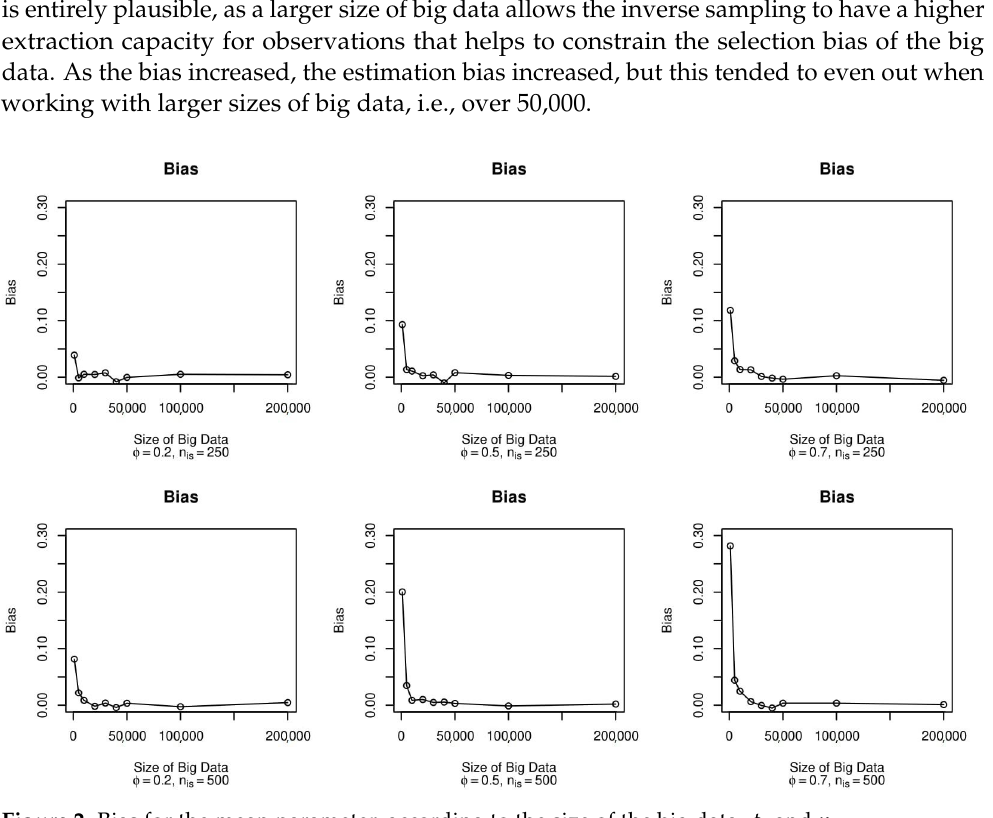
Figure 2. Bias for the mean parameter, according to the size of the big data, φ , and n is